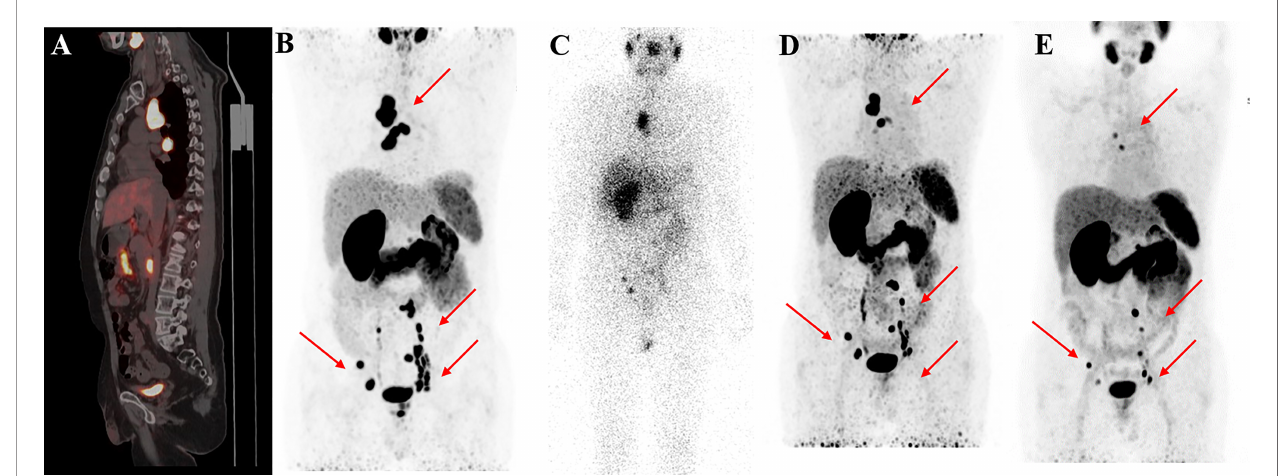
FIGURE 4 | 68 Ga-PSMA-11 PET/CT in a 55-year-old patient who underwent four cycles of 177 Lu-PSMA-I&T therapy. Baseline images (A, B) of multiple lymph node metastases in the right subclavian area, mediastinum, retroperitoneum, and pelvis. Post-therapy image (C) showing higher 177 Lu-PSMA-I&T aggregation in primary and metastatic lesions. 68 Ga-PSMA PET/CT after the fi rst cycle (D) and after the third cycle (E) showing multiple decreased or disappeared